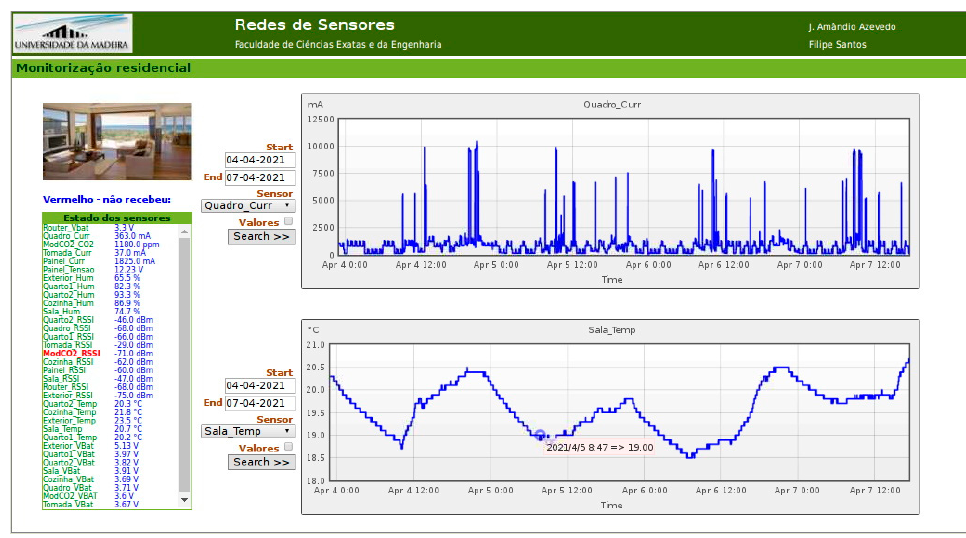
Figure 5. Webpage for data visualization.